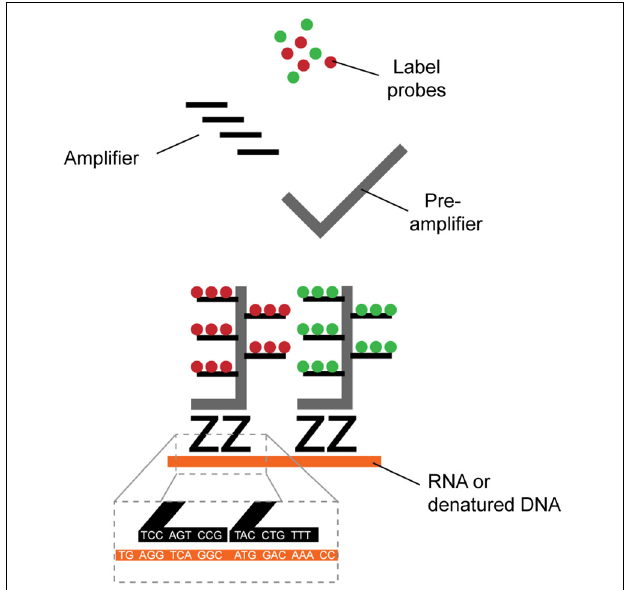
FIGURE 1 | Schematic representation of branched DNA signal amplification technologies. A pair of “Z” probes co-anneal on two 20-mer target RNA or DNA sequences (roots). The flanking regions of the Z probes are next further targeted by a subsequent probe (trunk) on which multiple sites for further fluorescent amplification are present (branches). The extreme improbability of stochastic yet close proximity annealing of two totally independent Z probes and the robust amplification provides excellent signal-to-noise ratio, allowing single-cell detection.